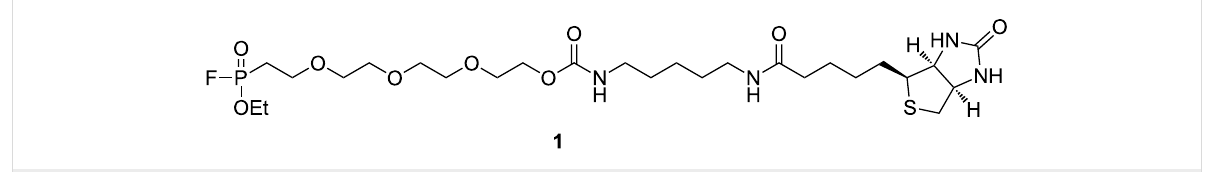
Figure 1: Structure of FP–PEG–biotin 1